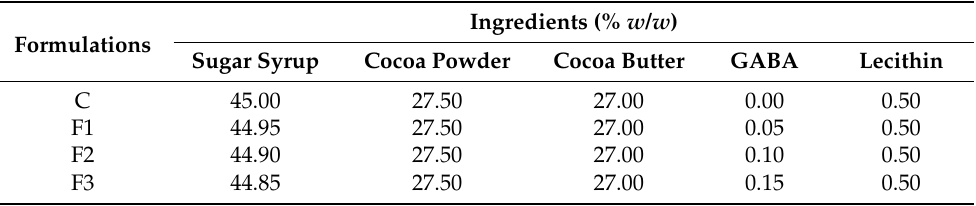
Table 1. Formulation of the control and GABA-enriched dark chocolates.